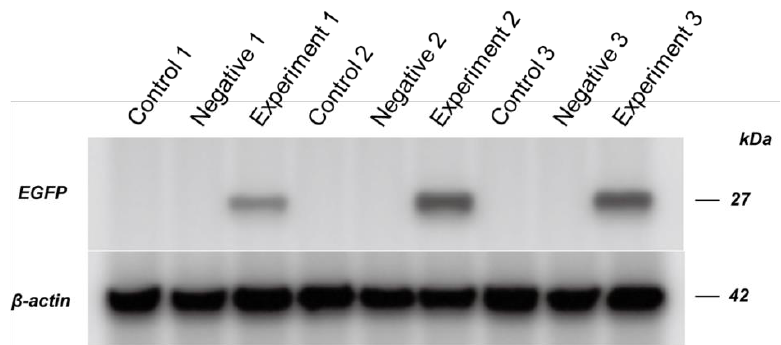
Figure 4. Western blot analysis of EGFP expression in clone viral RNA injected A. mellifera pupae. The control group pupae were injected with PBS; the negative control injected with a mutated clone with a stop codon; the experimental group was injected with the clone, SBV-IRES-EGFP. Three A. cerana larvae in the P2 group were also analyzed using Western blot. Because